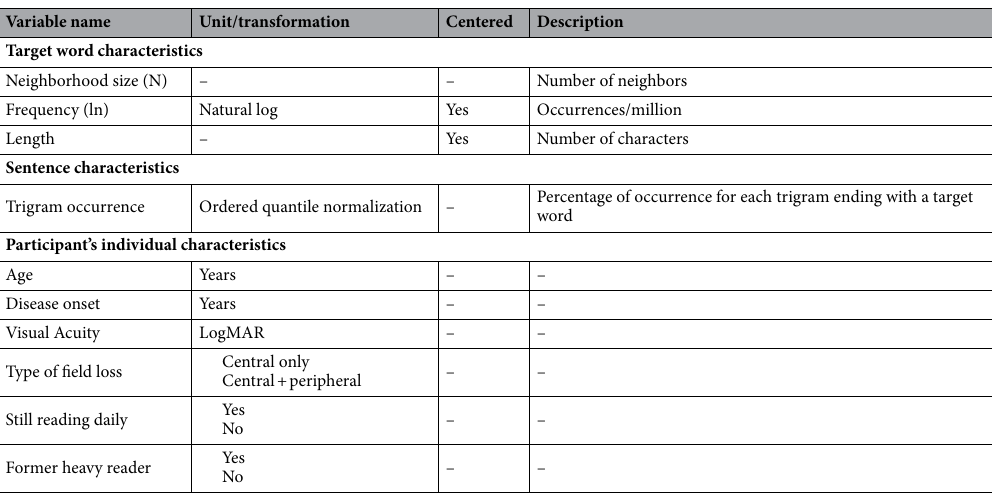
Table 2. Description of the different factors included as independent variables in the linear mixed-effects